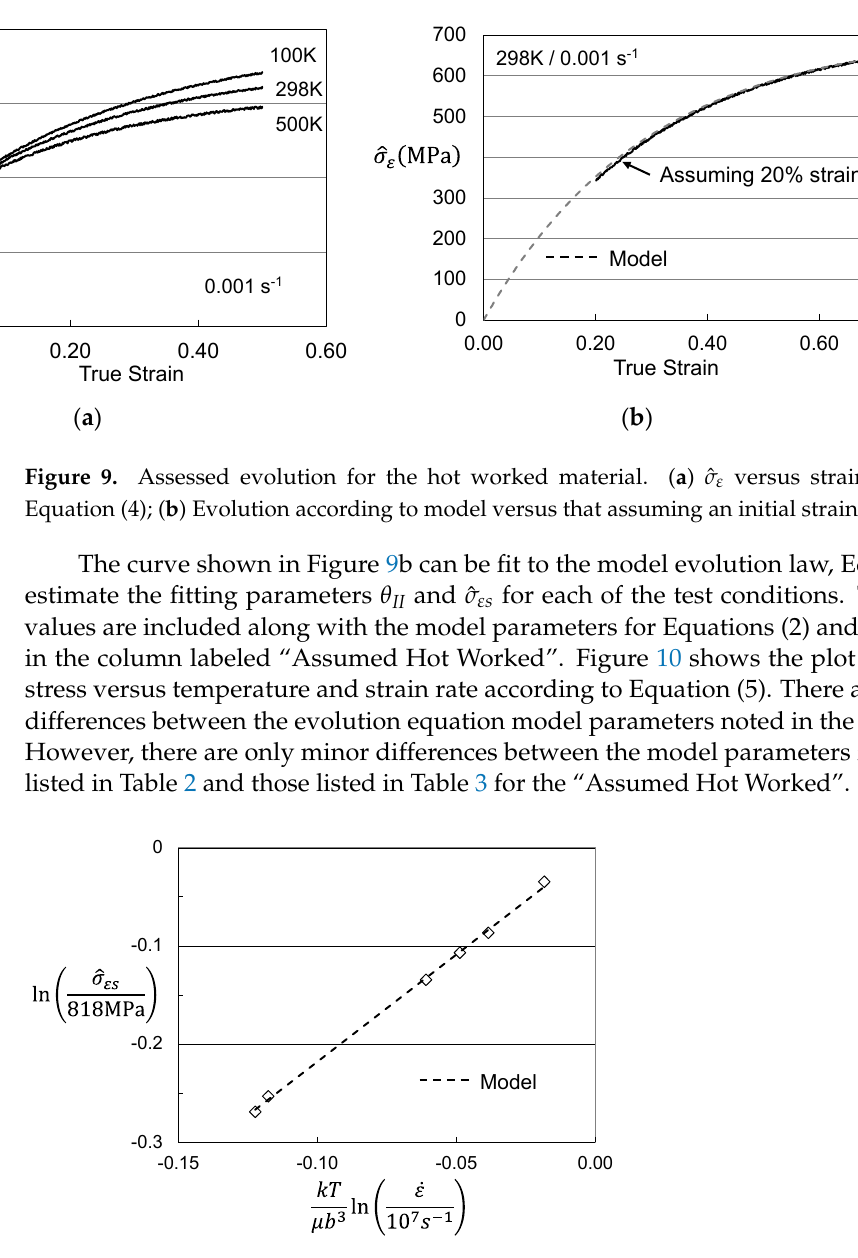
Figure 10. Saturation threshold stress for hot worked material with 20% initial strain.